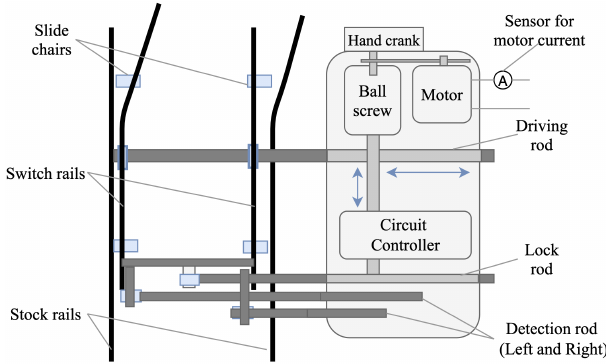
Figure 1. Railway switch system